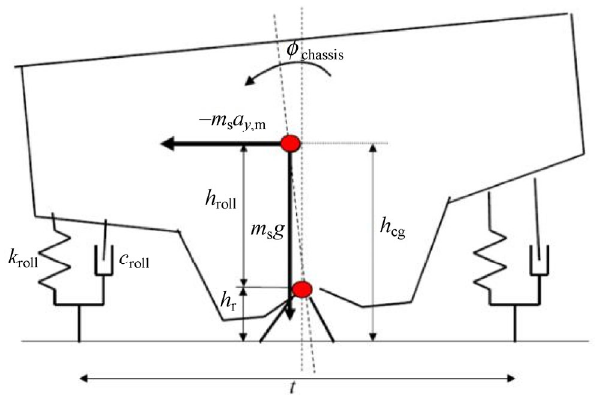
Fig. 8 The schematic of 1DOF roll vehicle model. Reproduce with permission from Ref. [68]. Copyright Singh, 2012.